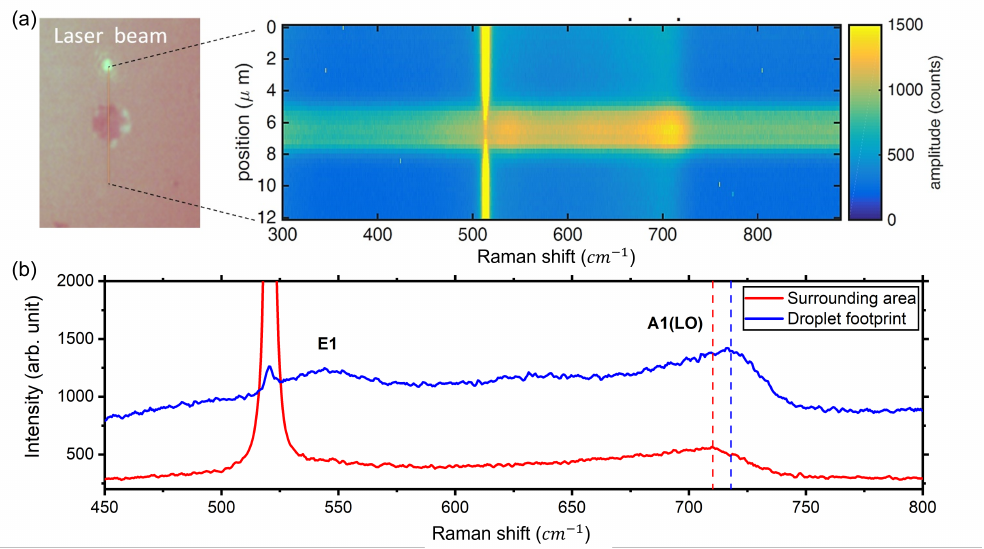
Figure 3. Line scan ( a ) and spot scan ( b ) micro-Raman spectroscopy across the footprint of a metal droplet, revealing the increase in Ga concentration in the droplet footprint with respect to the surroundings. The measured Raman shifts of the A1(LO) peaks are 710 cm − 1 (red line) and 718 cm − 1 (blue line), corresponding to an indium concentration of 19% and 13%